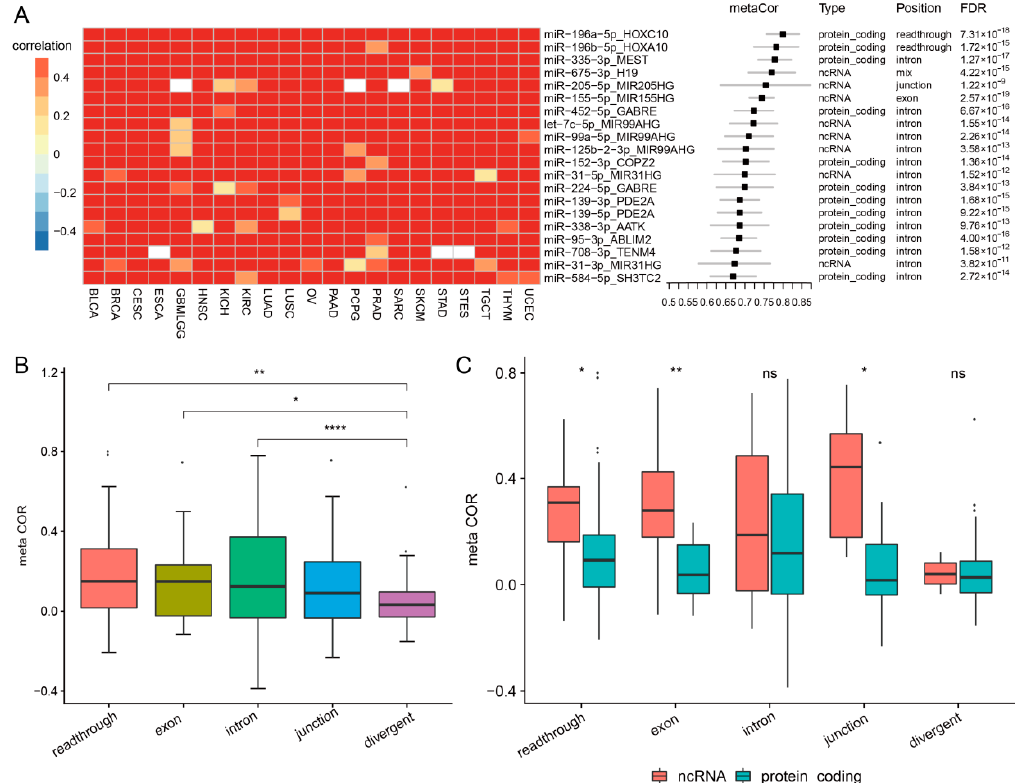
Figure 1. Meta analysis result of all cancers. ( A ). The top 20 coexpressed miRNA-host pairs. ( B ). Meta-correlation on miRNA-host pairs broken into subtypes, readthrough, exonic, intronic, junction and divergent. ( C ). Meta-correlation on miRNA-host pairs broken into protein-coding and noncoding genes. * p < 0.05, ** p < 0.01, **** p < 0.0001.